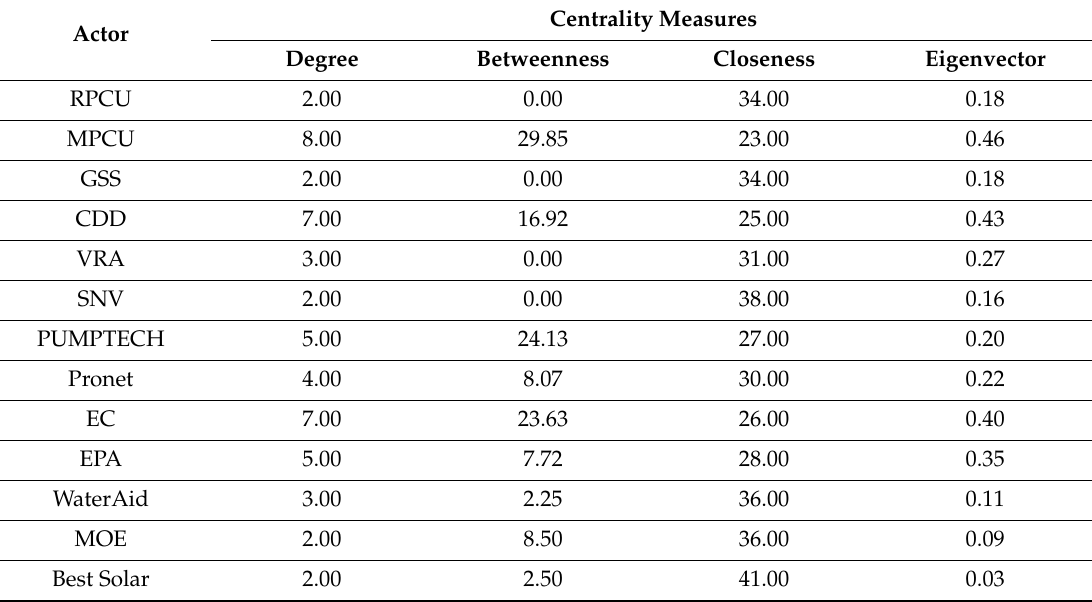
Table 2. Centrality scores for actors in the